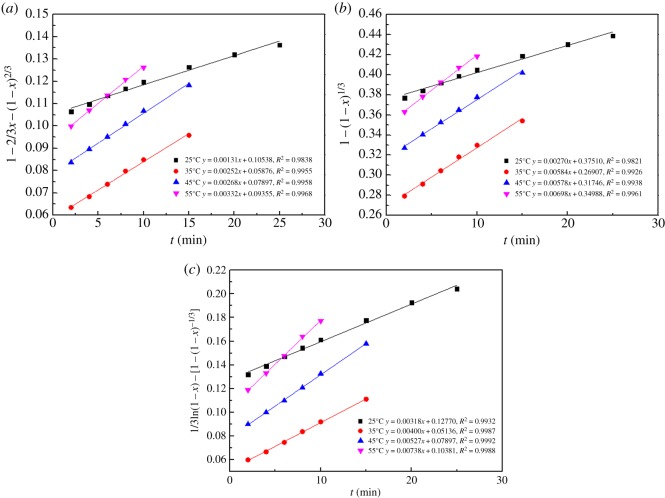
Plot of (a) 1 − 2/3x − (1 − x)2/3, (b) 1 − (1 − x)1/3 and (c) 1/3ln(1 − x) − [1 − (1 − x)−1/3] versus time for various temperatures.